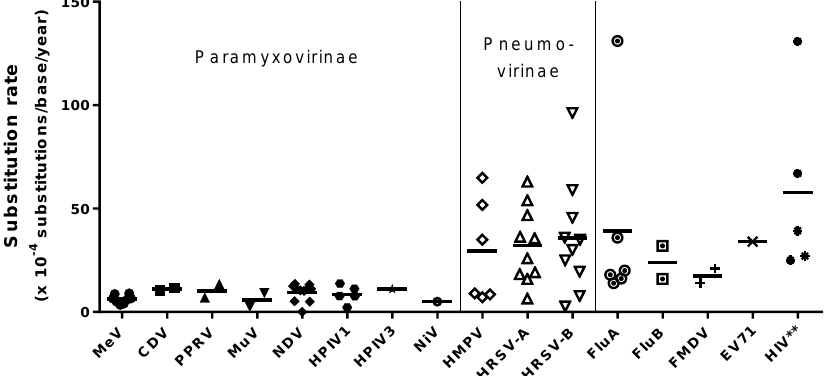
Figure 1. Reported substitution rates for selected viruses with RNA genomes. Each point represents a reported estimate of the substitution rate for the indicated virus. Estimates include measurements made from one or more gene sequences (N, F or H/HN/G genes) and/or the entire genome sequence. Horizontal bars indicate the mean for each virus. ** Human immunodeficiency virus (HIV) is a retrovirus and is included in this figure for comparison.